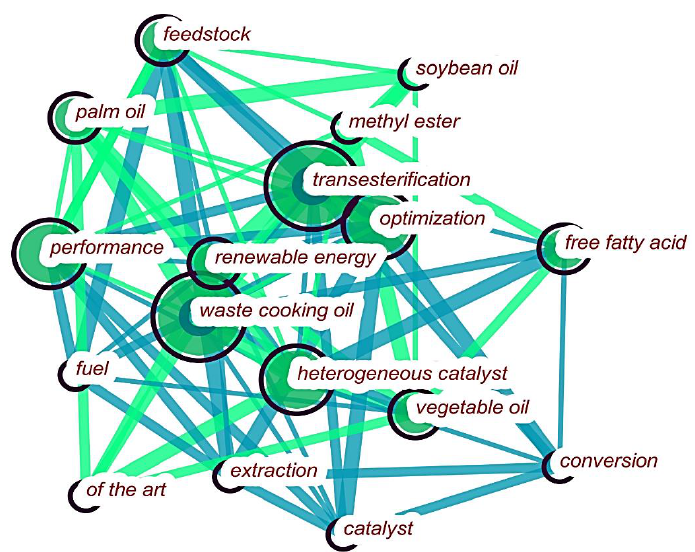
Figure 8. Keyword visualization network (January 2020 to December 2021).